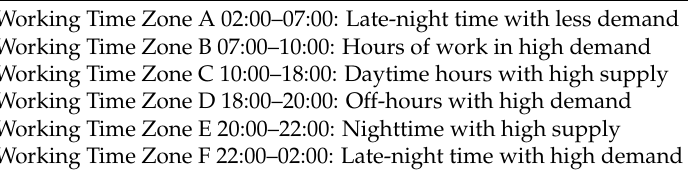
Table 4. Categorized working time by supply and demand.